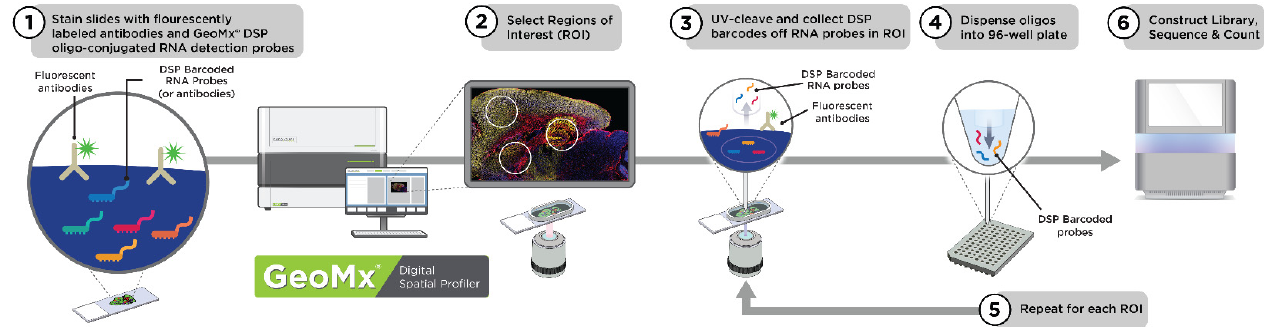
Figure 1. GeoMx workflow with NGS readout. The sequence of steps in the GeoMx workflow may be grouped into three phases: slide preparation (1), GeoMx instrument run (2–5) and readout (6). During slide preparation, a high-plex mixture of photocleavable oligo-linked probes (RNA shown) and morphology reagents are applied to the tissue section (1). Slides are loaded into the GeoMx instrument for a series of automated steps. After the researcher selects ROIs (2), the GeoMx instrument illuminates each area-of-illumination (AOI) with UV light to collect and deposit the photo-released oligos into a microtiter plate (3,4). Collection is repeated (5) to produce an AOI collection plate, where each well corresponds to a pool of photocleaved oligos from one AOI on the tissue. For NGS readout (6), each AOI (or well) is uniquely indexed during library preparation and can be pooled into one sequencing run.